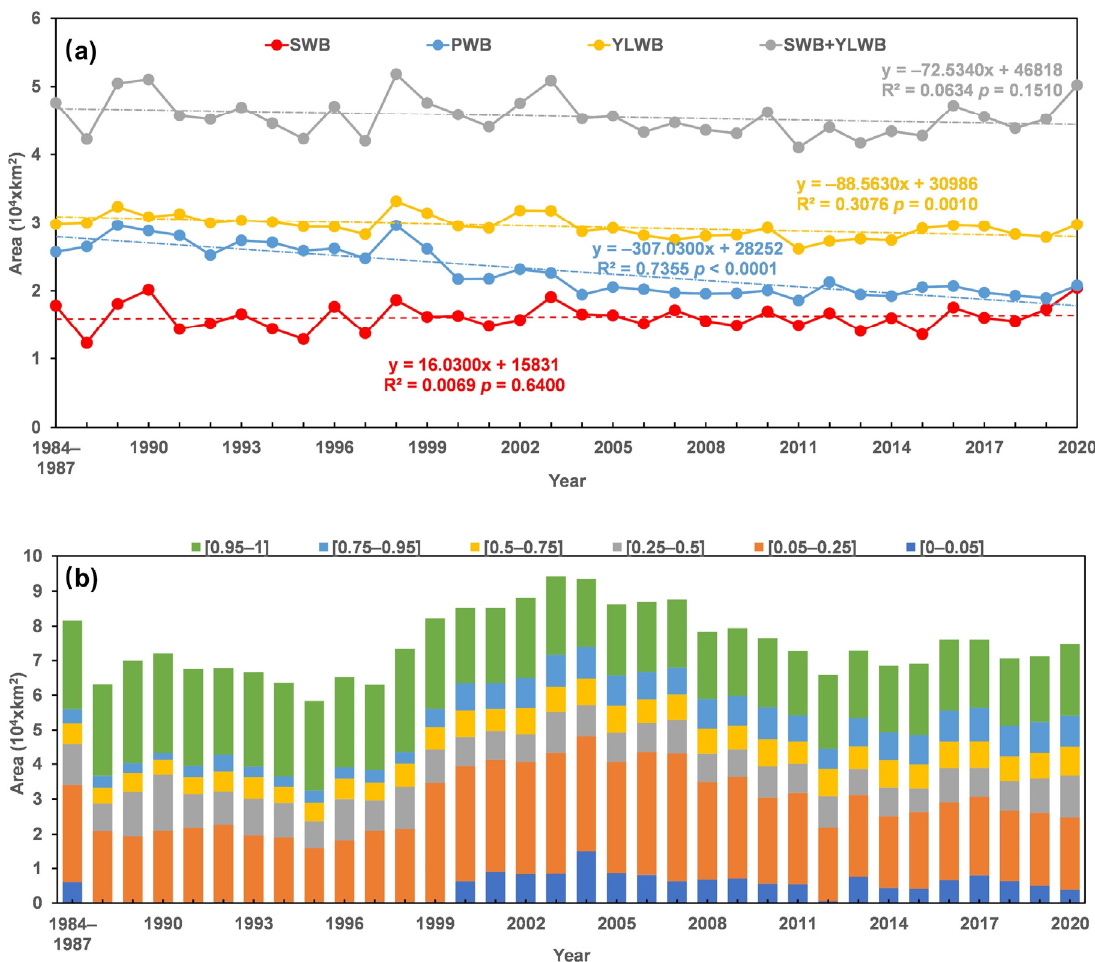
Figure 8. ( a ) The temporal variation in the surface water area for di ff erent water body types and ( b ) water area distribution for di ff erent water frequencies between 1984 and 2020 in the MLYP.